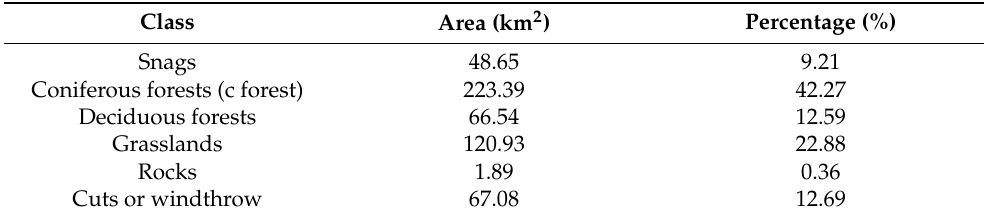
TANAP), source: Sentinel-2 3 October 2015.